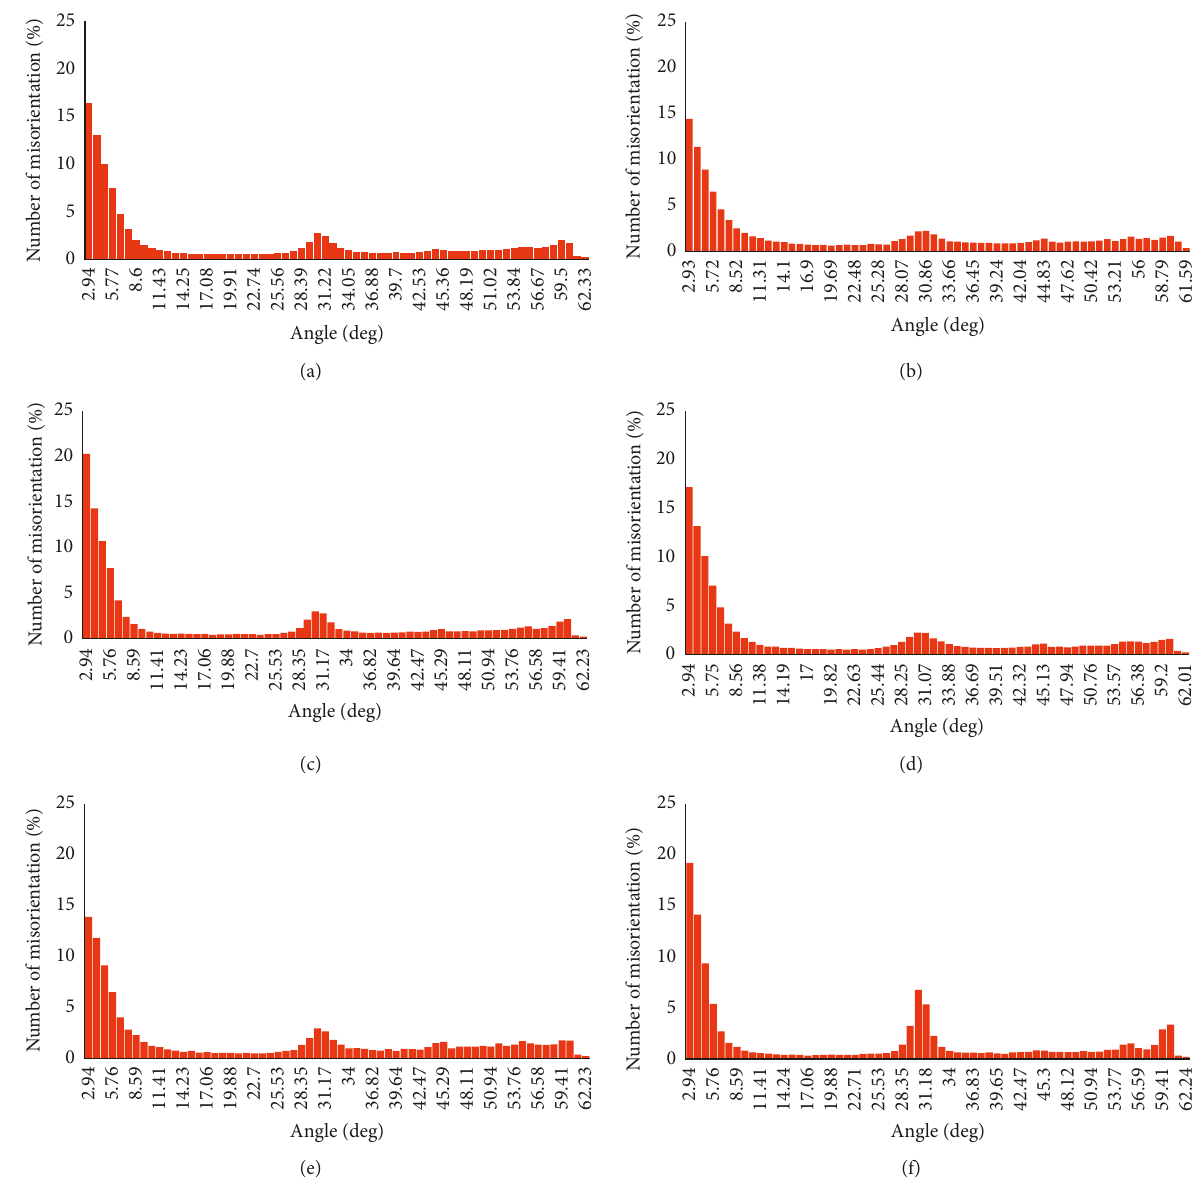
Figure 5: Misorientation distribution in warm rolled steels. (a) RT (d) RT 830 ° C, RR 60%, (e) RT 870 ° C, RR 30%, and (f) RT (cid:30) (cid:30) (cid:30) (cid:30) Table 3: Effect of the rolling temperature and the rolling reduction on yield point elongation and fluting intensity in mild steel. Rolling temperature of mild steel ( °